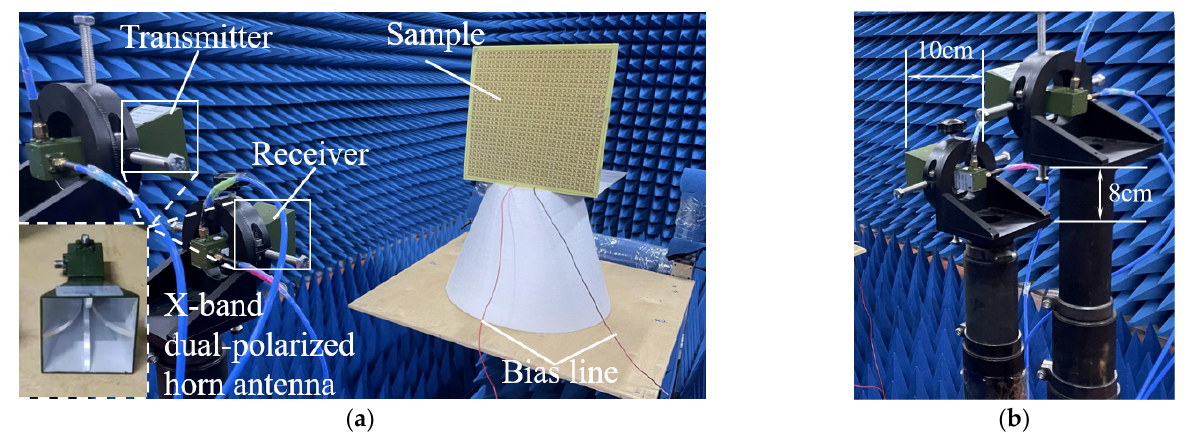
Figure 8. Experimental setup of electric fields. ( a ) Measurement setup and environment. ( b ) Relative position of the antennas.